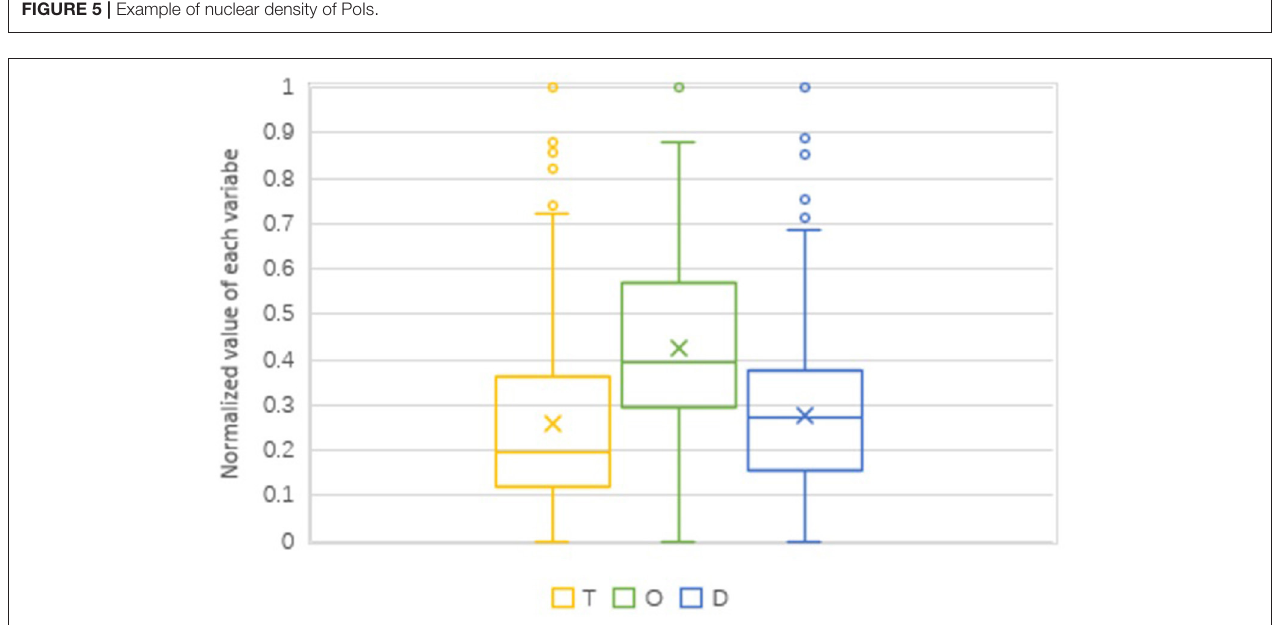
FIGURE 5 | Example of nuclear density of PoIs.